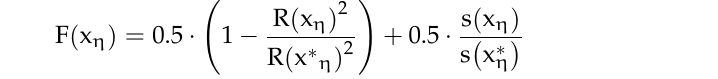
Figure 2. The pseudo code of the genetic algorithm.